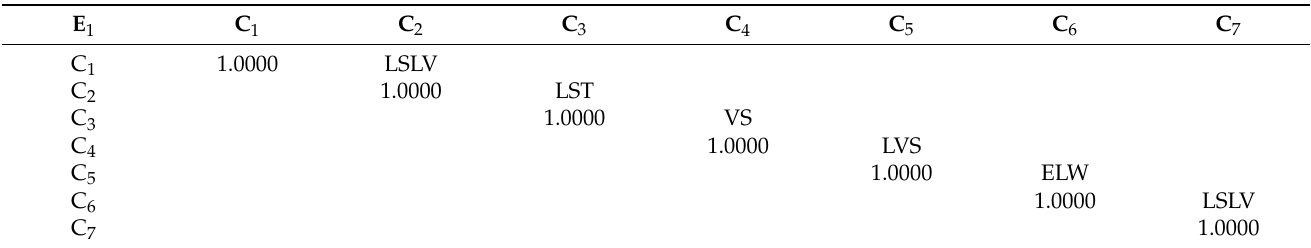
Table 5. Fuzzy preference pairwise comparisons matrix of evaluator 1 in